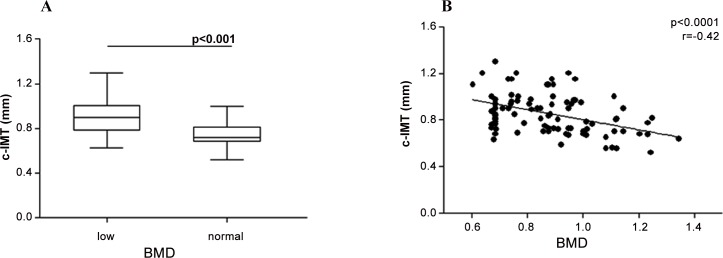
c-IMT and BMD in HIV infected subjects.A. A higher c-IMT in HIV positive patients with a low BMD than in patients with a normal BMD was found. Horizontal bars represent the median. The upper and lower whisker indicate the third quartile +1.5 [Inter Quartile Range (IQR)] and first quartile -1.5(IQR). B. A linear regression analysis showed a negative correlation between c-IMT and BMD.